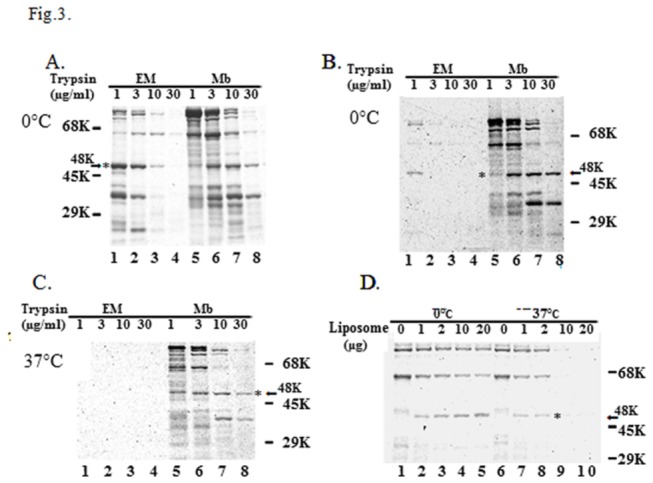
Proteolysis of membrane-integrated SecA and various phospholipid-integrated SecA with trypsin.(A) Liposomes (20 μg) of E. coli lipid mixtures and 20 μg BA13 inverted inner membrane (Mb) were mixed with SecA (10 μg) in 100 μl DTK buffer on ice. Trypsin treatment was undertaken at the concentrations indicated. (B) The same reactions were carried out as in panel (A), except that 1 μg of [35S]SecA was used. (C) The same reactions were carried out as in panel (A) except that the reactions were incubated at 37 °C for 15 min, chilled on ice prior to the addition of trypsin. (D) 2 μg of [35 S]SecA was mixed with different amounts of liposomes (as indicated). Half of the reaction mixtures were incubated at 37 °C for 15 min, while the other half were incubated on ice. All samples were cooled on ice following the reactions. Trypsin (final concentration 1 μg/ml) treatment was used, as described in the Materials and Methods.